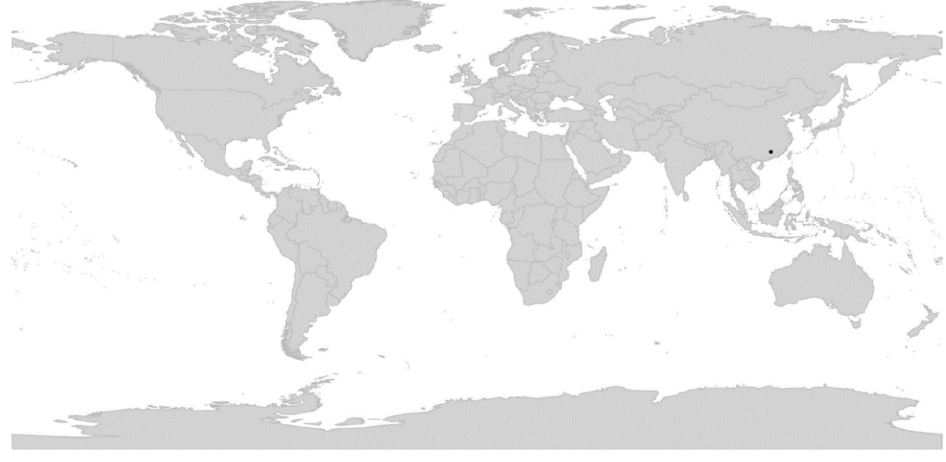
Figure 15. Global distribution of Viola sect. Danxiaviola . Discussion .—The single species in the section, V. hybanthoides , is phylogenetically iso- lated within the north hemisphere allopolyploid tangle, based on both ITS and chloroplast sequences [90]. The combined features of the larger bottom petal and much smaller lateral and upper petals is unique in Viola but found recurrently in most bilaterally symmetrical genera of the Violaceae, such as genera currently being segregated from the former poly- phyletic Hybanthus , and sisters to Viola , Noisettia and Schweiggeria [3]. We infer that V. hy- banthoides is probably a CHAM + MELVIO meso-allotetraploid, judging from its chromo- some number (2 n = 20) which in sect. Viola and sect. Delphiniopsis reflects 4 x , the small size of its chromosomes and tricolporate pollen which both reflect a certain time since the pol- yploidisation, and its phylogenetic placement nested within a tetraploid clade [90] (Figure 6).